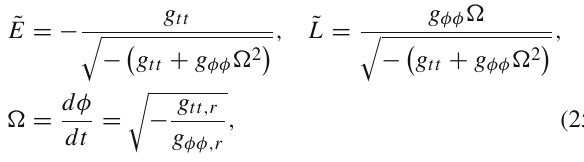
nant of the metric on the equatorial plane. The marginally stable circular orbit is given by V (cid:15)(cid:15)